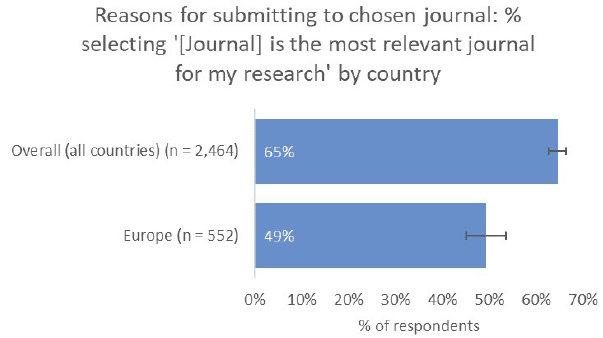
Figure 14. Relative importance of relevance in determining choice of journal for Europe-based authors.